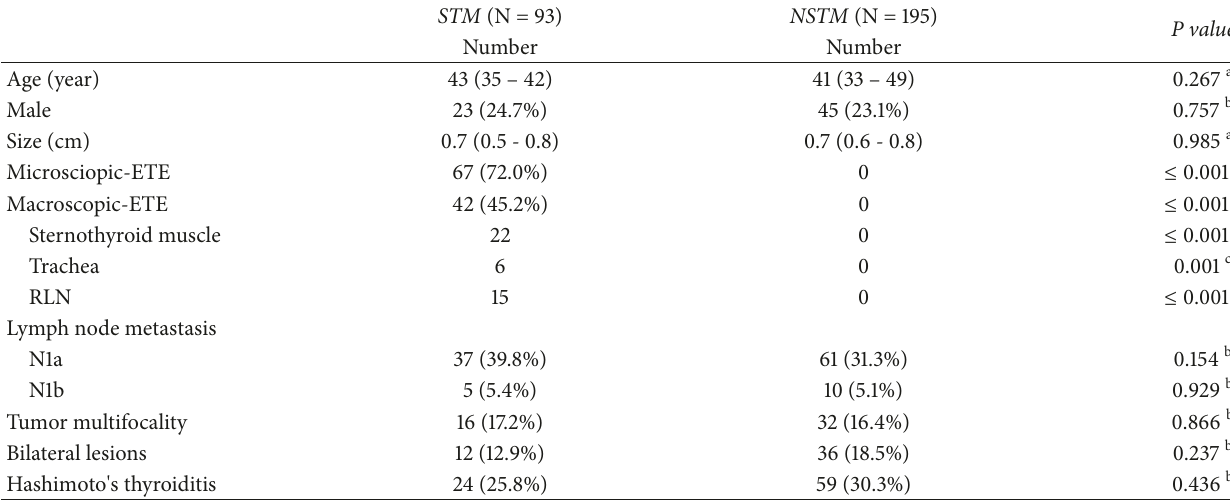
Table 1: Characteristics of the study